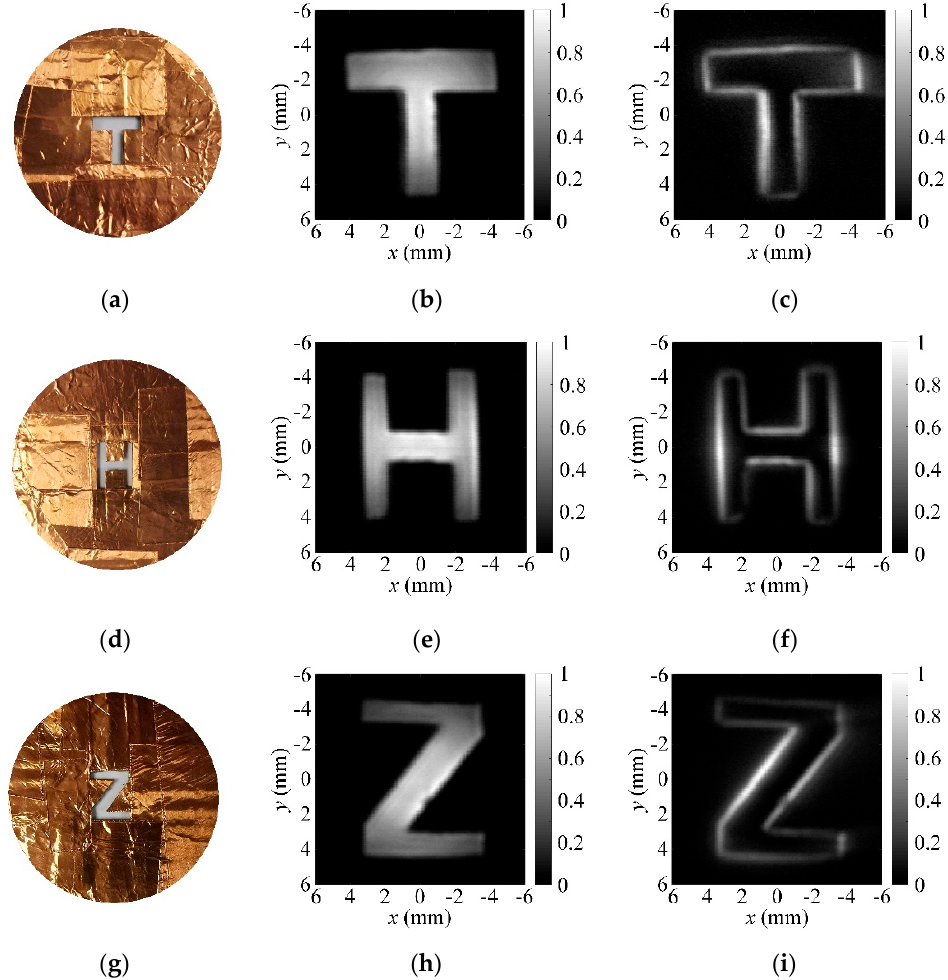
Figure 5. Experimental results for the letters objects. ( a , d , g ) The optical images of “T”, “H” and “Z”. ( b , e , h ) The THz bright-field (BF) imaging results. ( c , f , i ) The THz SSF imaging results.